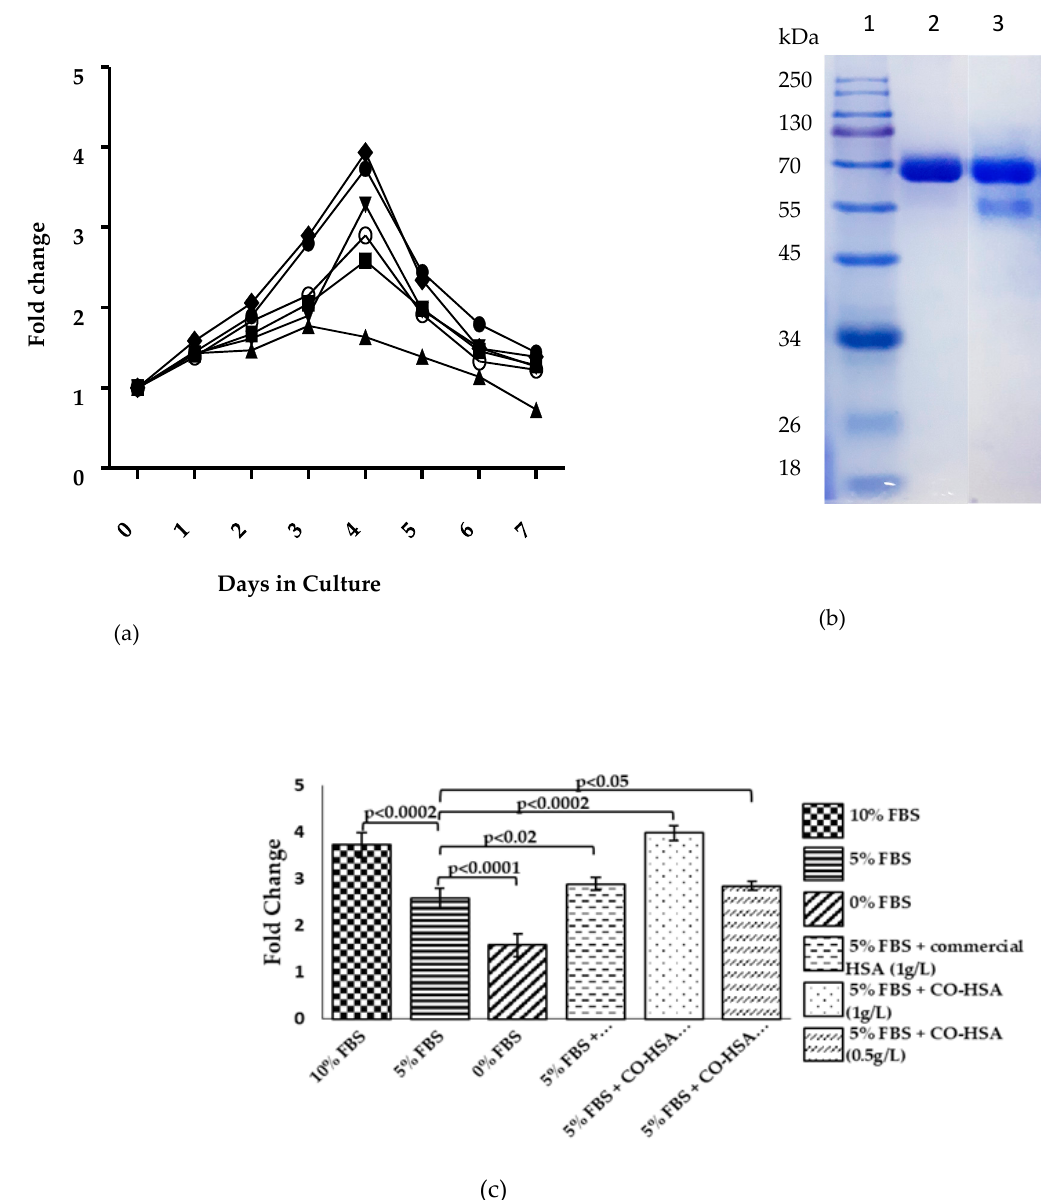
Figure 6. ( a ) Cell viability (MTT) assay with Vero cell lines. Fold change in proliferation was measured in the absence of any fetal bovine serum (FBS) ( ▲ ), 5% FBS ( ■ ) or 10% FBS ( ● ), 5%FBS + 1 g/L commercial HSA ( ▼ ), 5% FBS + purified HSA 0.5 g/L ( ○ ), or 5% FBS + purified HSA 1g/L ( ◆ ). ( b ) SDS-PAGE analysis of purified HSA from Clone # 14 cultivated on optimized medium. Lane 1: Marker, Lane 2: Commercial HSA (4 µg), Lane 3: 4 µl fast protein liquid chromatography (FPLC) fraction. ( c ) The statistical significance of the difference was determined by paired t -test taking 5% FBS as standard reference for cell proliferation experiments.